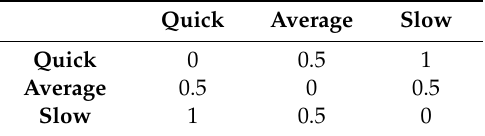
Table 2. Comparison criterion for feature “speed”.